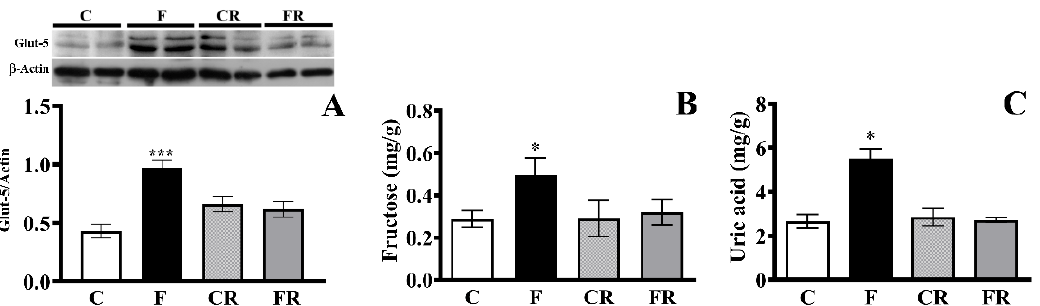
Figure 1. Hippocampus fructose handling. ( A ) Glut-5 level (with representative Western blot), ( B ) fructose and ( C ) uric acid concentrations in the hippocampi of control (C), fructose-fed (F), control rescued (CR), and fructose-rescued (FR) rats. Data are the means ± SEM of eight rats/group. * p < 0.05 versus control rats; *** p < 0.001 versus control rats. Source of variation: one-way ANOVA followed by Tukey’s post-test.